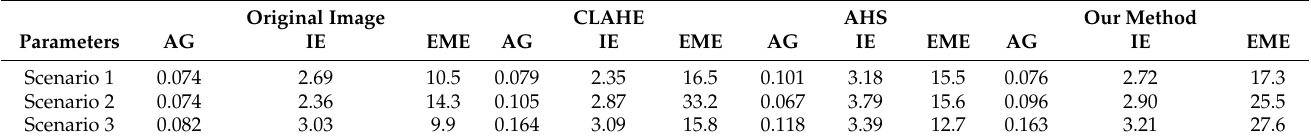
Table 2. Infrared image-enhancement algorithm processing result parameter comparison.